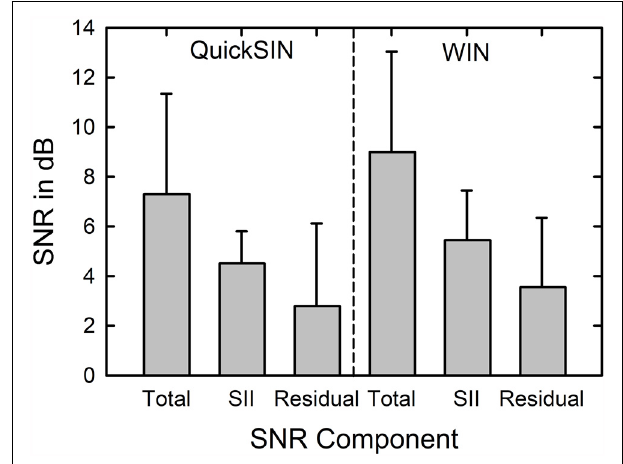
FIGURE 5 | Means and standard deviations (error bars) for the SNRtotal, SNRsii, and SNRresidual components for the 137 older adults in this study for the QuickSIN (left) and WIN (right). SNRtotal is the measured SNR at SRT, SNRsii is the SNR needed to achieve the normal-hearing SII for each listener, and SNRresidual = SNRtotal −